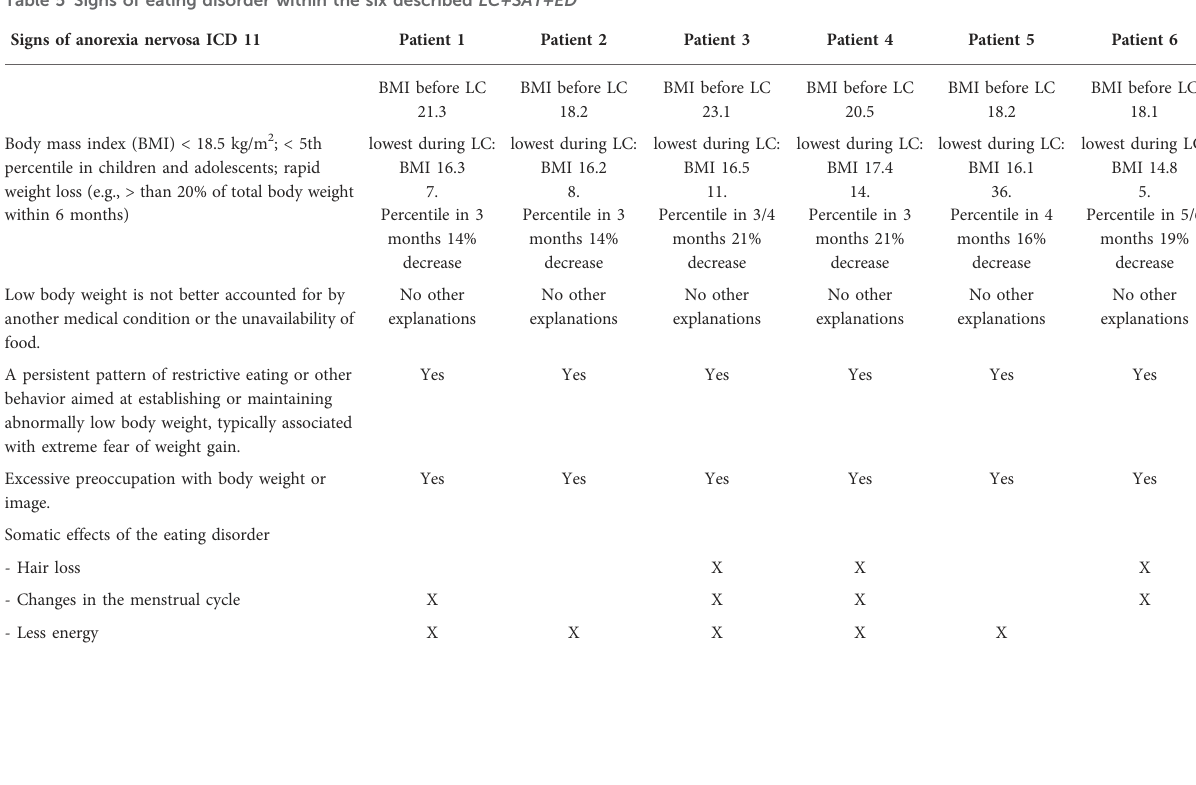
Table 5 Signs of eating disorder within the six described LC+SAT+ED Signs of anorexia nervosa ICD 11